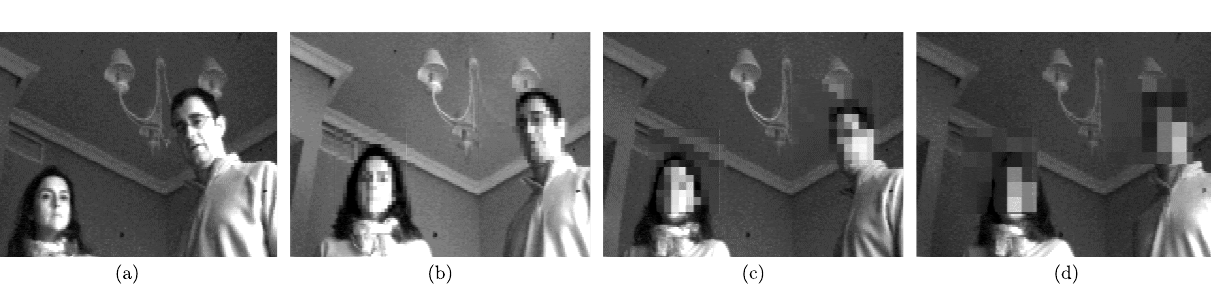
Figure 7. On-chip obfuscation without artifacts by exploiting the A-to-D conversion stage: ( a ) original image captured by the chip; ( b ) pixelation with 4 × 4 -px blocks; ( c ) pixelation with 8 × 8 -px blocks; ( d ) pixelation with 16 × 16 -px blocks.